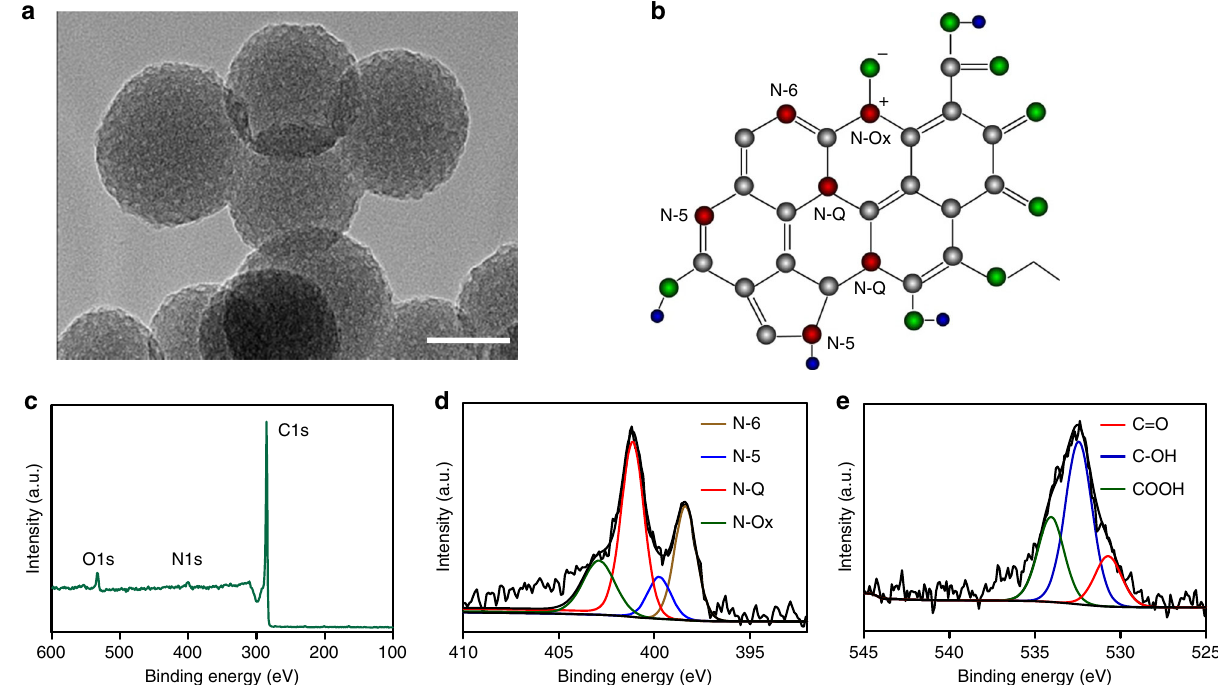
Fig. 1 Morphology and N doping analysis of N-PCNSs. a HRTEM image of N-PCNSs-3. Scale bar: 100 nm. b Schematic model of nitrogen and oxygen containing surface functionality in N-PCNSs-3. c XPS survey spectra of N-PCNSs-3. d N 1 s core-level XPS spectra of N-PCNSs-3. e O 1 s core-level XPS spectra of